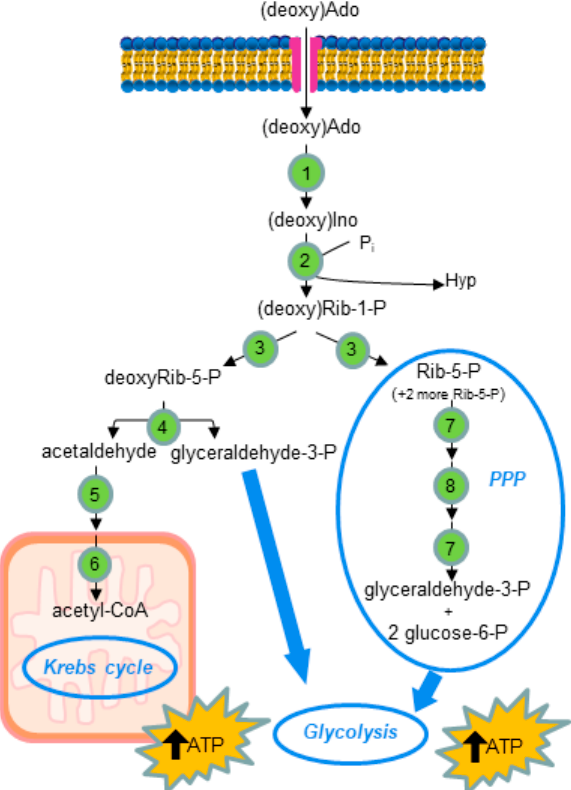
Figure 3. Schematic illustration of the uptake and utilization of (deoxy)Ado. The nucleoside enters the cell through ENT and is subjected to catabolic reactions. The destiny of the ribose moiety of the nucleoside is underlined. 1: Adenosine deaminase; 2: purine nucleoside phosphorylase; 3: phosphoribomutase; 4: deoxyRib-5-P aldolase; 5: aldehyde oxidase; 6: acetyl-CoA synthetase; 7: transketolase; 8: transaldolase. PPP: pentose phosphate pathway (non oxidative branch).